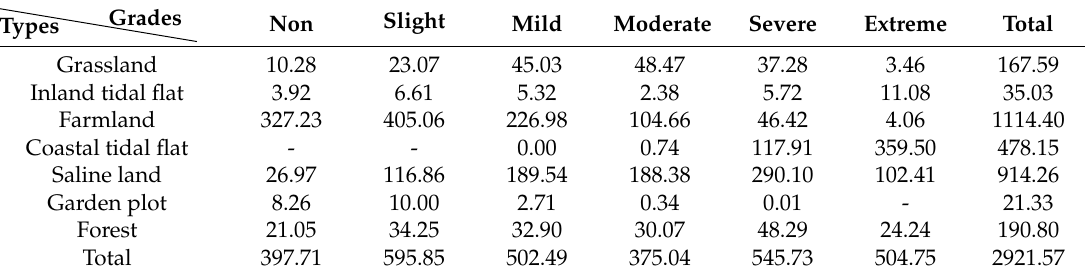
Table 8. Area of main land-use types distributed in each EV grade (unit: km 2